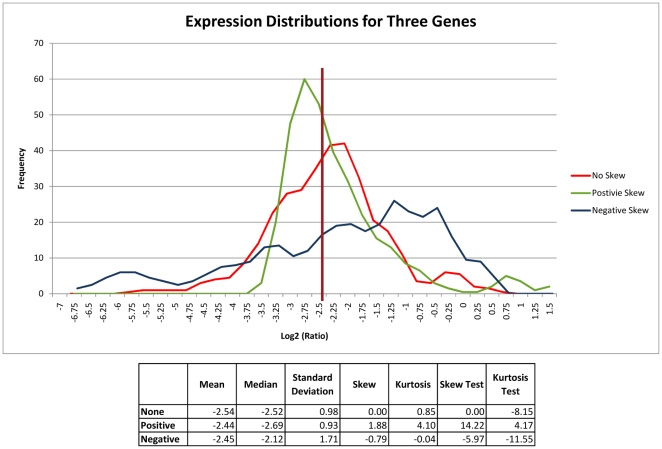
Distributions of Three Sample Genes from the TCGA GBM data.The expression distributions across all 340 GBM samples of three, representative genes with approximately equal means, medians, and standard deviations are plotted. Note that, for each sample, the mean and median are nearly equal and the standard deviation is approximately equal to 1. These descriptive statistics suggest a Gaussian distribution. However, the three distributions are significantly unequal, a finding only reflected in the measurements of skew. Mild kurtotic effects can also be observed. Test statistics for skew and kurtosis are calculated as described in the text. (Note: The negatively skewed sample gene is TCEAL2]211276_at], the positively skewed sample gene is CENTA1 [90265_at], and the unskewed gene is CYFIP2 [21578_s_at].).